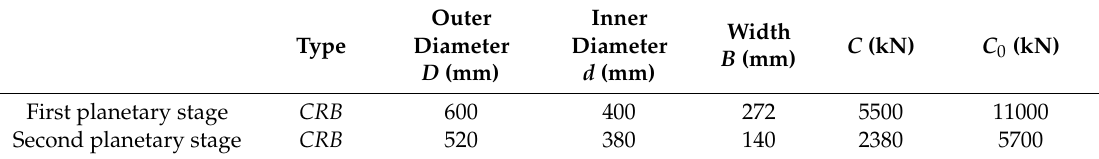
Table 6. Parameters of bearing of planet